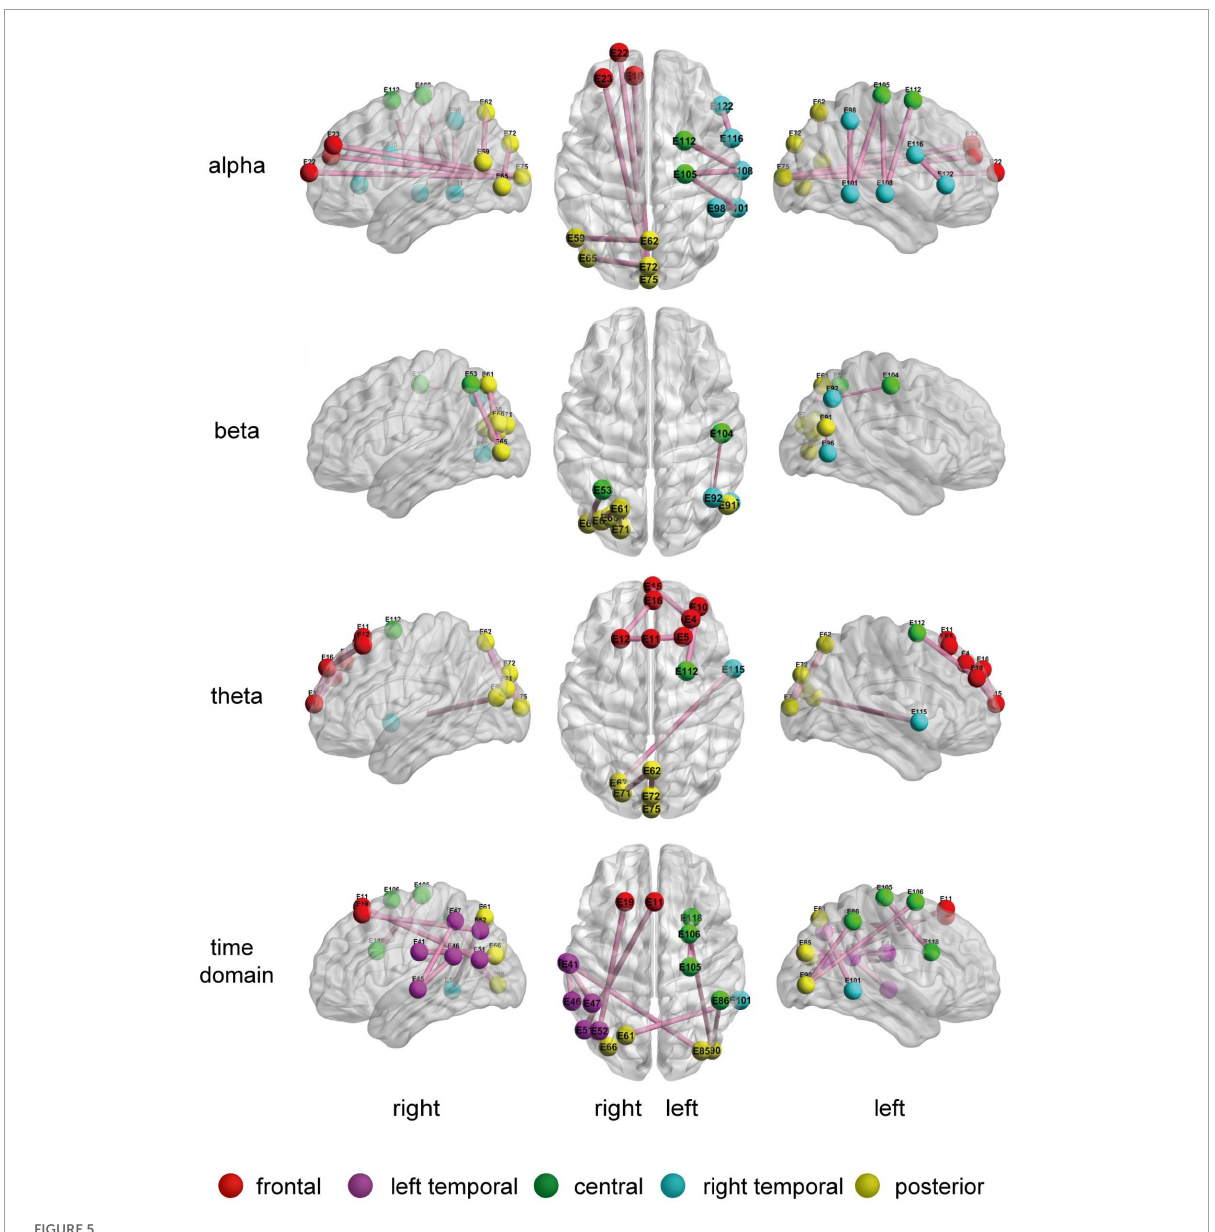
FIGURE5 The 10 most frequently selected connection diagrams for different